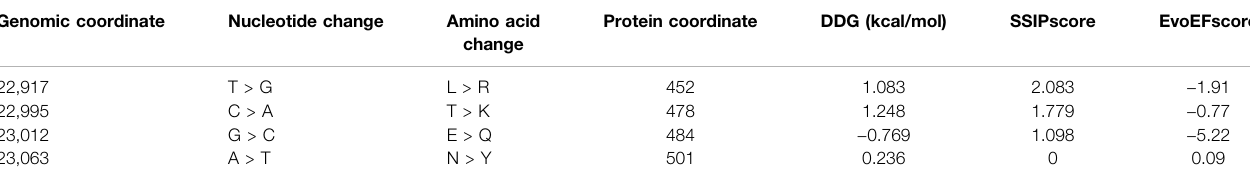
TABLE 6 | Binding af fi nity of the mutations in RBD region of Spike protein and human ACE2 protein. Genomic